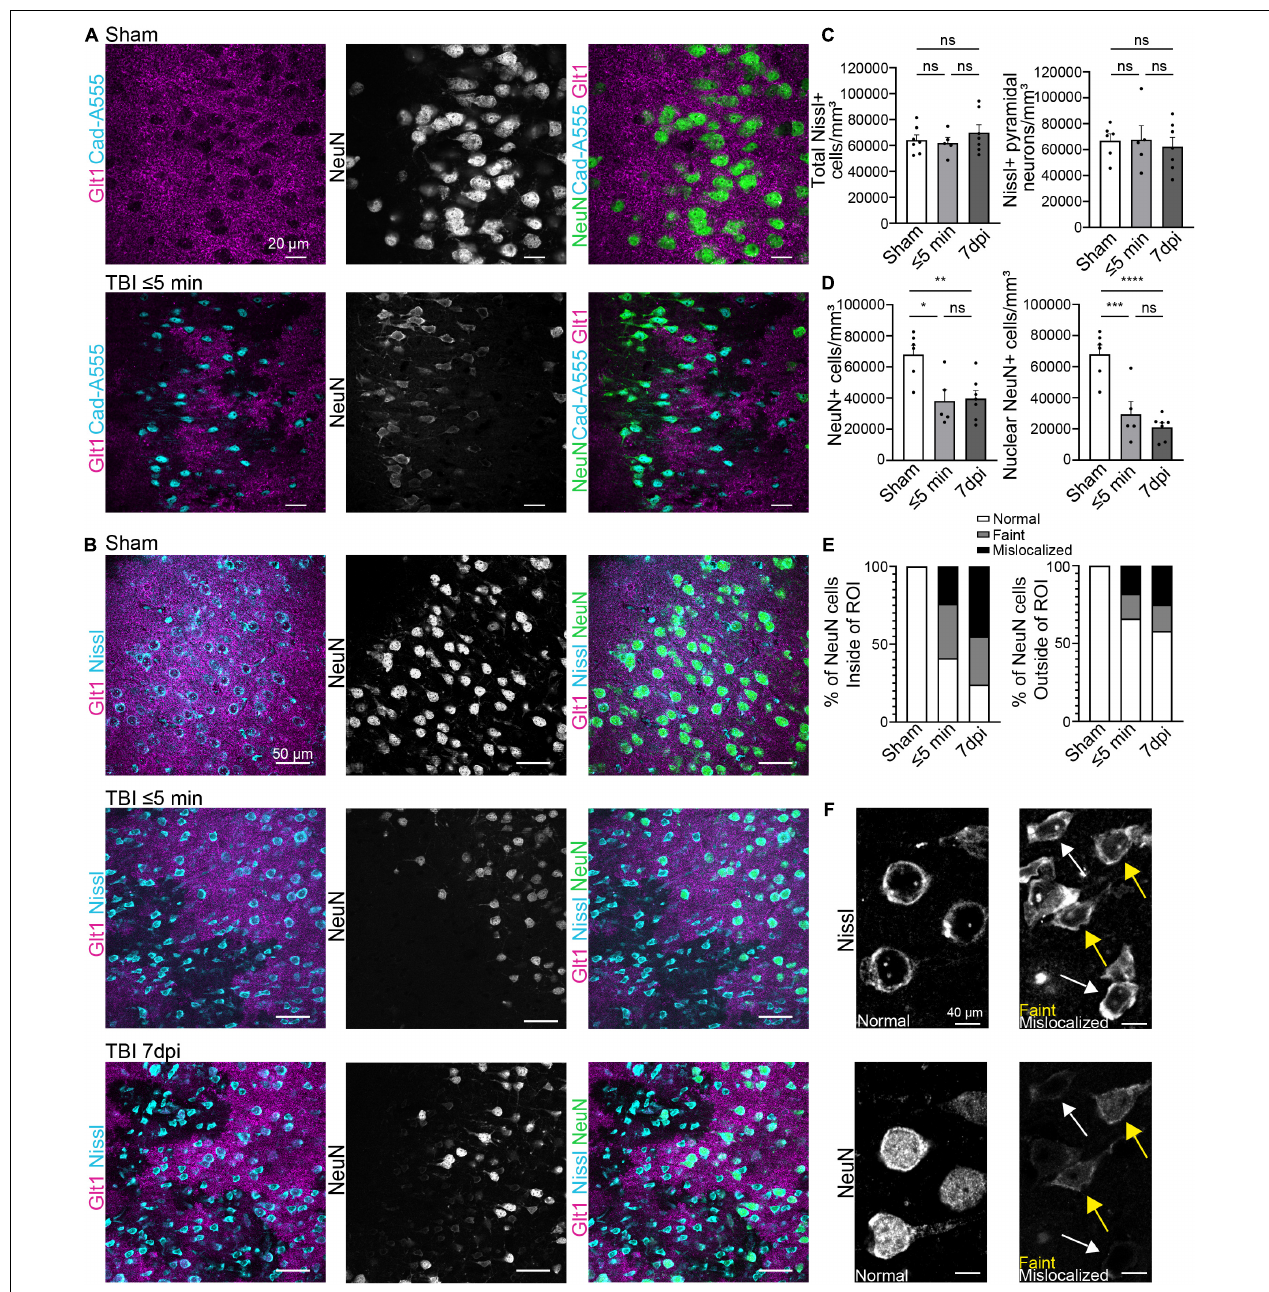
FIGURE 1 | Blood-brain barrier leakage occurs after a single mTBI leading to an atypical NeuN response. (A) Cadaverine leakage occurs within 5 min of a single TBI hit and Cadaverine overlaps with regions of atypical neurons. Panels in the top row show Sham and panels on the bottom row are TBI ≤ 5 min (Blue: Cad-A555, Magenta: Glt1, B&W: NeuN, Green: NeuN). (B) NeuN expression in mature neurons was reduced in atypical areas within 5 min after a single hit and persisted up to 7 dpi. Nissl staining labeled all pyramidal neurons including neurons with Atypical NeuN expression throughout all time points. Panels in the top row show Sham, panels on the center row are TBI ≤ 5 min and panels on the bottom row are TBI 7 dpi (Blue: Nissl, Magenta: Glt1, B&W: NeuN, Green: NeuN). (C) All Nissl expressing cells were quantified as density (cell/mm 3 ) in atypical areas and plotted per animal. (Sham: 64,188 ± 3,951, n = 7; ≤ 5 min: 61,929 ± 4,186, n = 5; 7 dpi: 69,927 ± 6,080, n = 7). One-way ANOVA: non-significant, p -value = 0.5287. Post-hoc analysis (Tukey HSD): Sham vs. ≤ 5 min: p = 0.9501; Sham vs. 7 dpi: p < 0.6789; ≤ 5 min vs. 7 dpi: p = 0.5395. Then only pyramidal Nissl expressing cells were quantified (Sham: 66,887 ± 5,302, n = 6; ≤ 5 min: 67,637 ± 10,843, n = 5; 7 dpi: 62,390 ± 6,998, n = 7) One-way ANOVA: non-significant, p -value = 0.8660. Post-hoc analysis (Tukey HSD): Sham vs. ≤ 5 min: p = 0.9976; Sham vs. 7 dpi: p = 0.9029; ≤ 5 min vs. 7 dpi: p = 0.8822. (D) All NeuN+ cells and NeuN+ nucleus were quantified as density (cell/mm 3 ) in regions of atypical astrocytes and plotted per animal. Statistics for all NeuN+ cells (Sham: 68,063 ± 6,018, n = 6; ≤ 5 min: 38,112 ± 7,231, n = 5; 7 dpi: 39,727 ± 5,131, n = 7). One-way